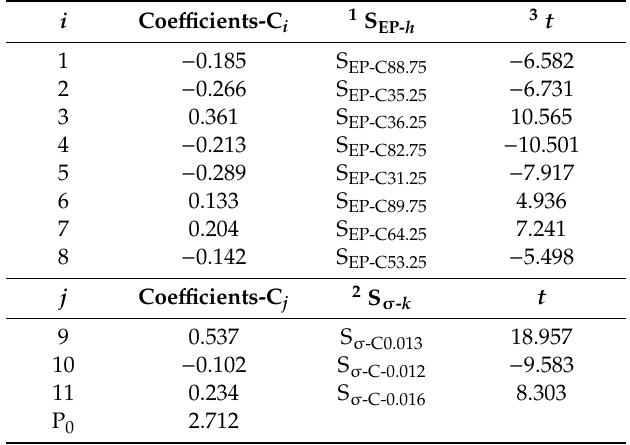
Figure 1. The squared correlation coefficient ( R 2 ) versus parameter number for the training data set. Table 1. Coefficients ( C i ), parameters ( S EP- h and S σ - k ) and the t values for Equation (1).